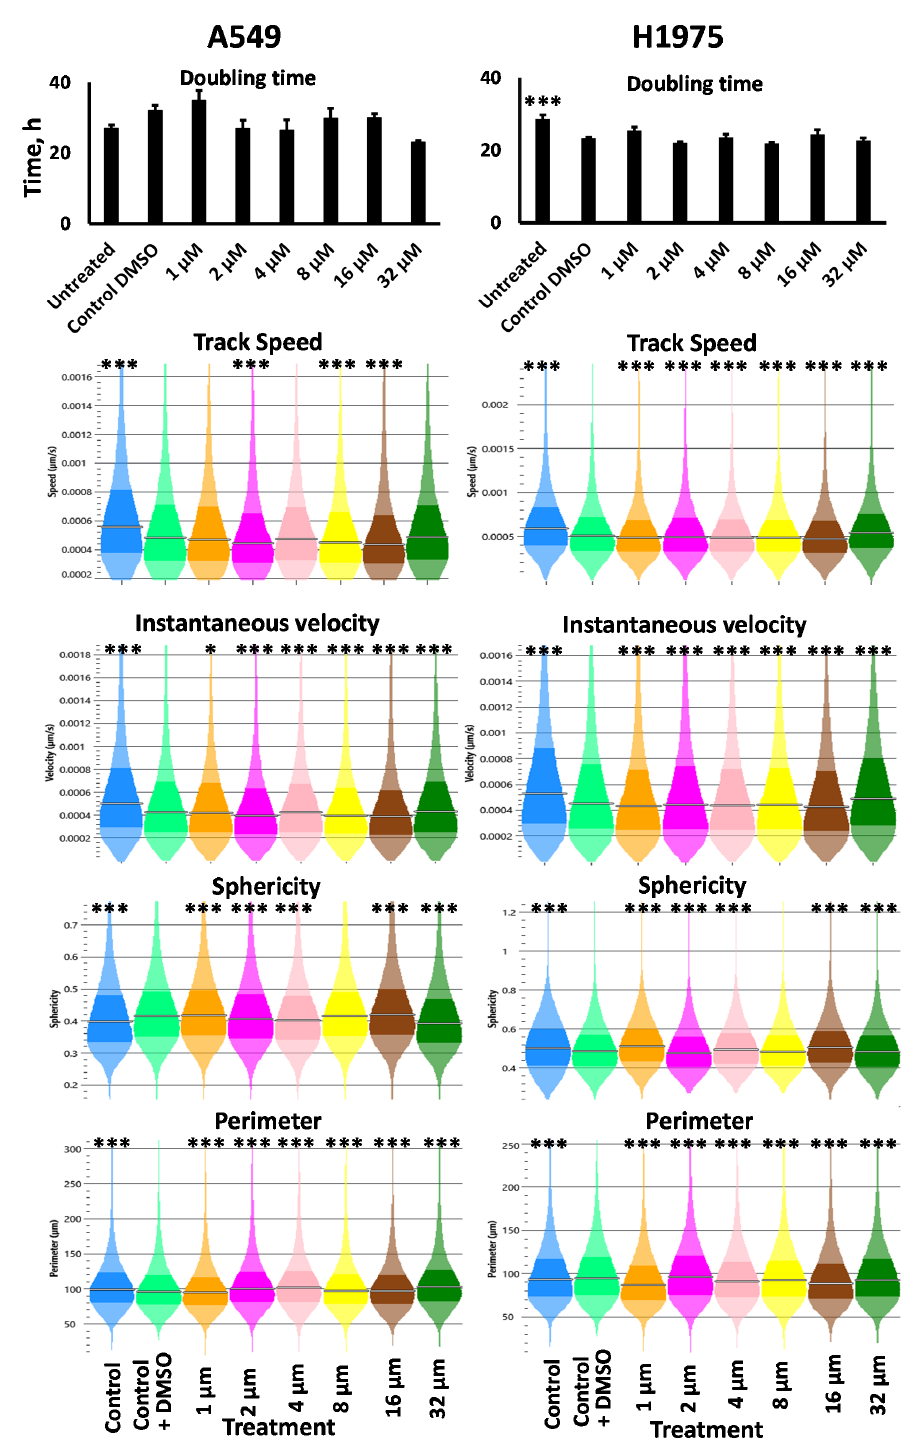
Figure 3. Cell doubling time, track speed, instantaneous velocity, sphericity, and perimeter were monitored for approximately 24 h using Livecyte QPI microscopy. A549 ( left ) and H1975 ( right ) cells were cultured in 24-well plates, and CTX at varying concentrations was introduced (similar to cytotoxicity analysis above). All samples were in triplicate wells. Cell doubling time data are the average of three wells per treatment group, with standard error of the mean. Colored graphs indicate value distribution based on values from all individually measured cells. The statistical analysis is one-way ANOVA, followed by Tukey’s post-hoc test. All statistical analyses reported are in comparison to the control-DMSO group. *: p < 0.05; ***: p <